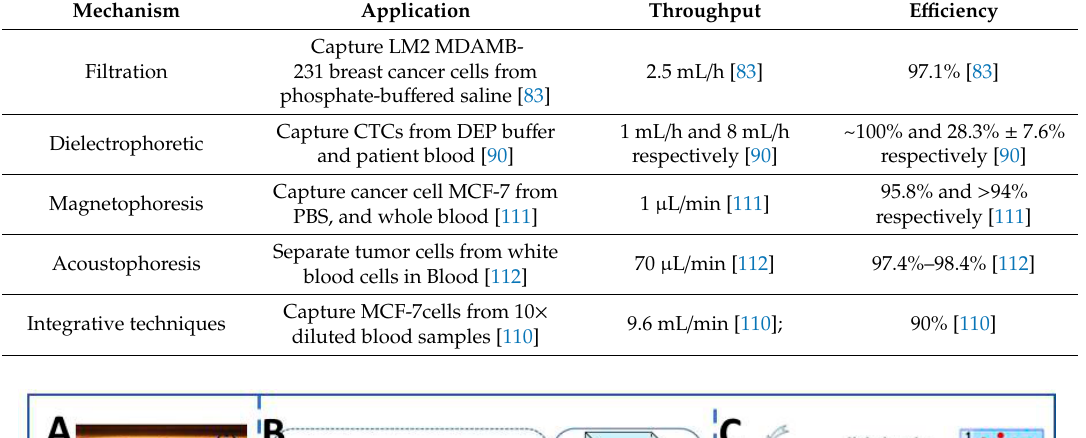
Table 1. The display and compare the throughput and efficiency of diverse mechanisms for capturing circulating tumor cells (CTCs) from mimicking/real blood samples.